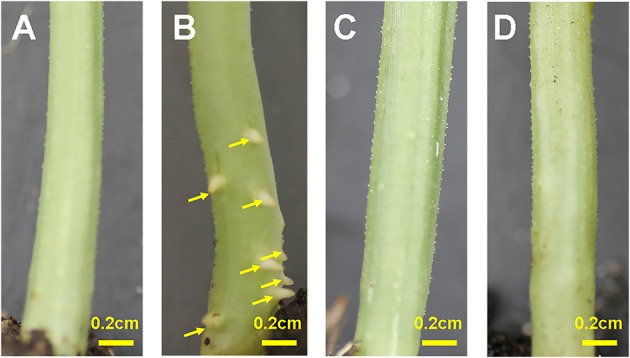
Adventitious root formation on hypocotyls of cucumber seedlings. (A) Zaoer-N control; (B) Zaoer-N waterlogging; (C) Pepino control; (D) Pepino waterlogging. The yellow arrows in the picture indicated the location of adventitious roots. The water level was kept at about 2 cm above the soil for 2 days and then removed for photography.